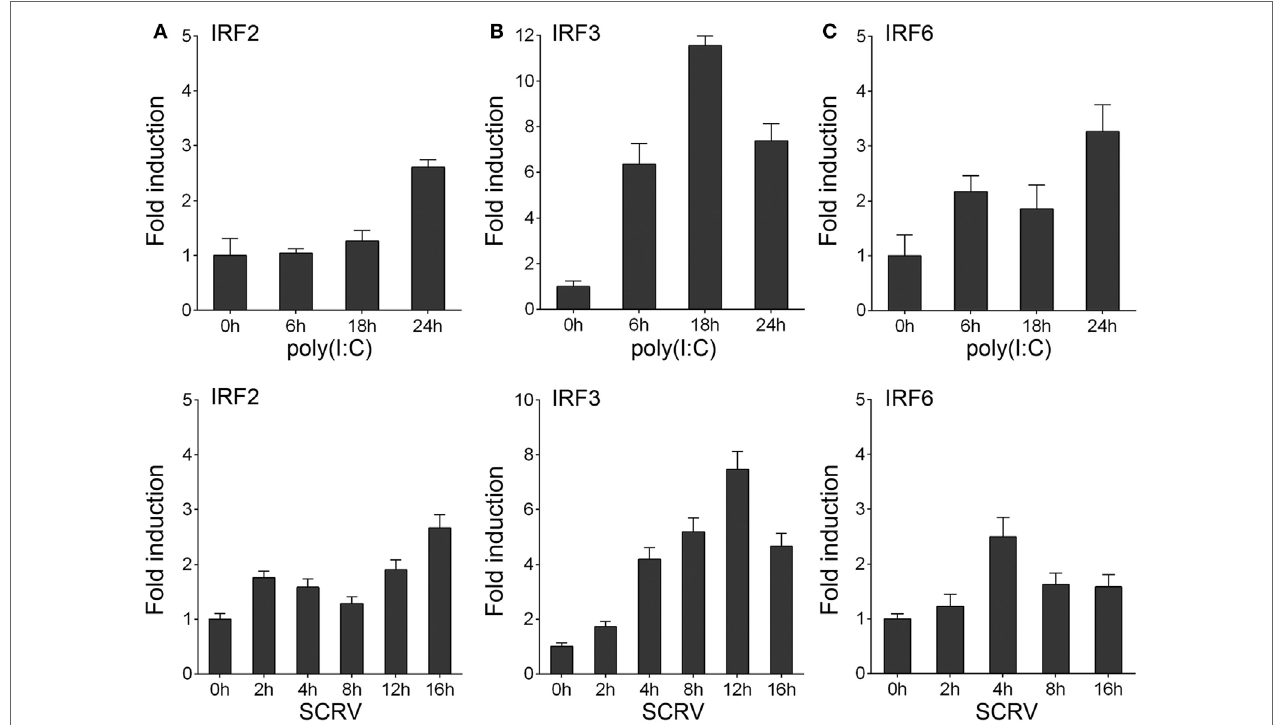
FigUre 1 | Inducible expression patterns of IRF3. (a–c) Miiuy croaker macrophages were seeded onto 12-well plate overnight and stimulated with poly(I:C) (2 µg/ml) for 6, 18, and 24 h, or SCRV (MOI = 5) for 2, 4, 8, 12, and 16 h. Then total RNAs were extracted to examine the expression of IRF2, IRF3, and IRF6 by qRT-PCR. The data were normalized to β -actin. Results are standardized to 1 in control